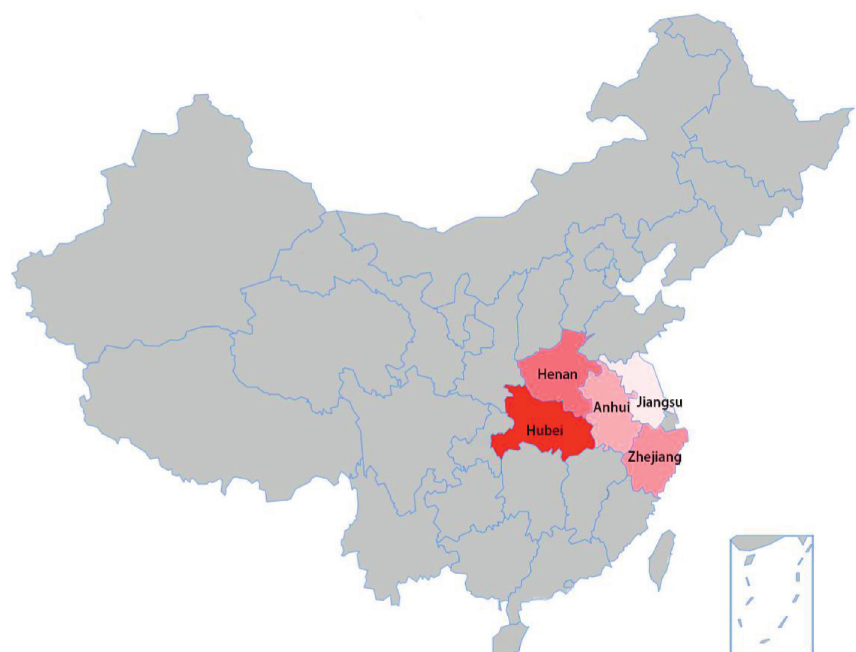
Figure 1: The location of Hubei, Anhui, Henan, Jiangsu, and Zhejiang. The color refers to the number of confirmed cases we collected in each region till Feb. 19, 2020. That is, Anhui, 887 cases, Henan 1279 cases, Jiangsu 577 cases, and Zhejiang 1137 cases.